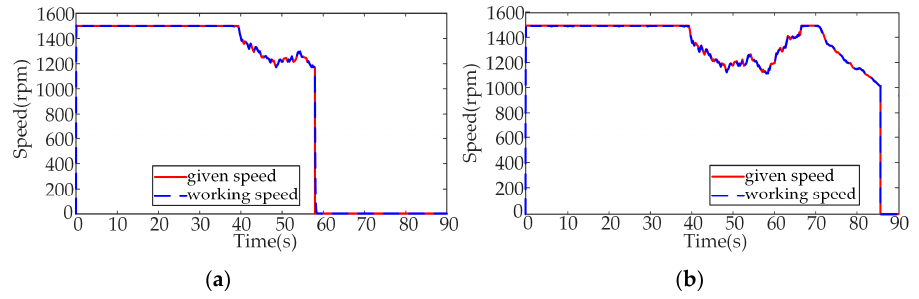
Figure 17. Speed curves. ( a ) Speed of G1; ( b ) speed of G2.